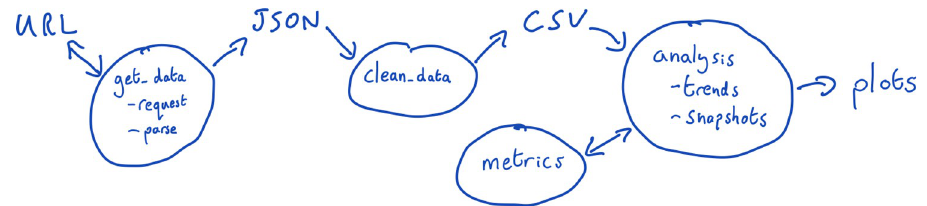
Fig 2. An example rough sketch for a text analysis project. The project involved programmatically downloading data, cleaning that data, analysing it using specific metrics, and producing plots. By sketching it out, you are able to see the general workflow and how different parts of the code can be thought of